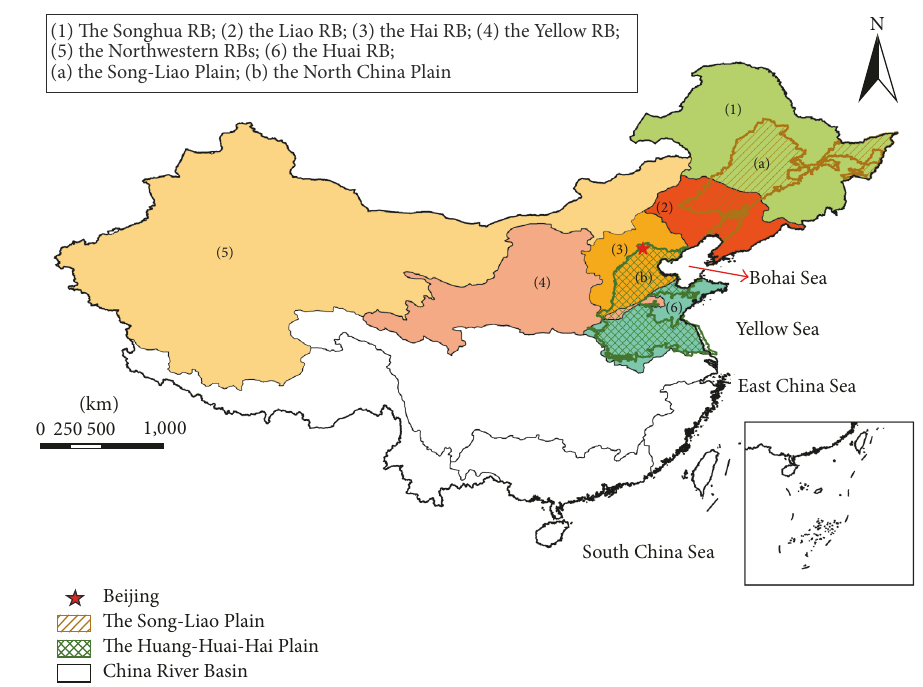
Figure 1: Schematic figure of ten river basins and two north plains in